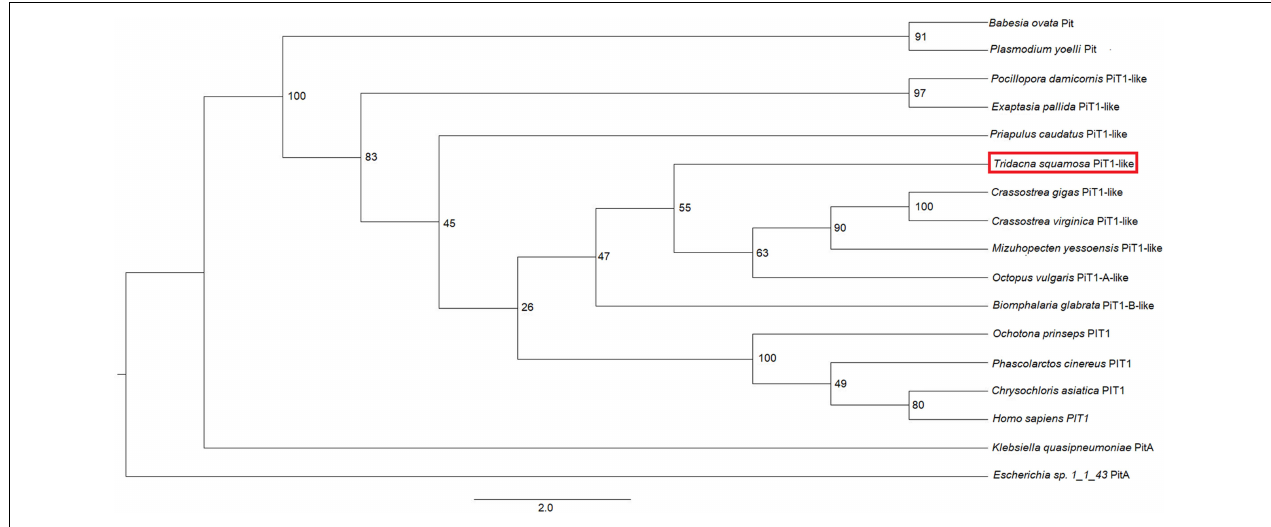
FIGURE 1 | Phenogramic analysis of the homolog of sodium-dependent phosphate transporter protein 1 (PiT1-like) from Tridacna squamosa . Numbers shown at each branch point represent bootstrap values from 1,500 replicates. PitA from Escherichia sp. 1_1_43 PitA is used as the